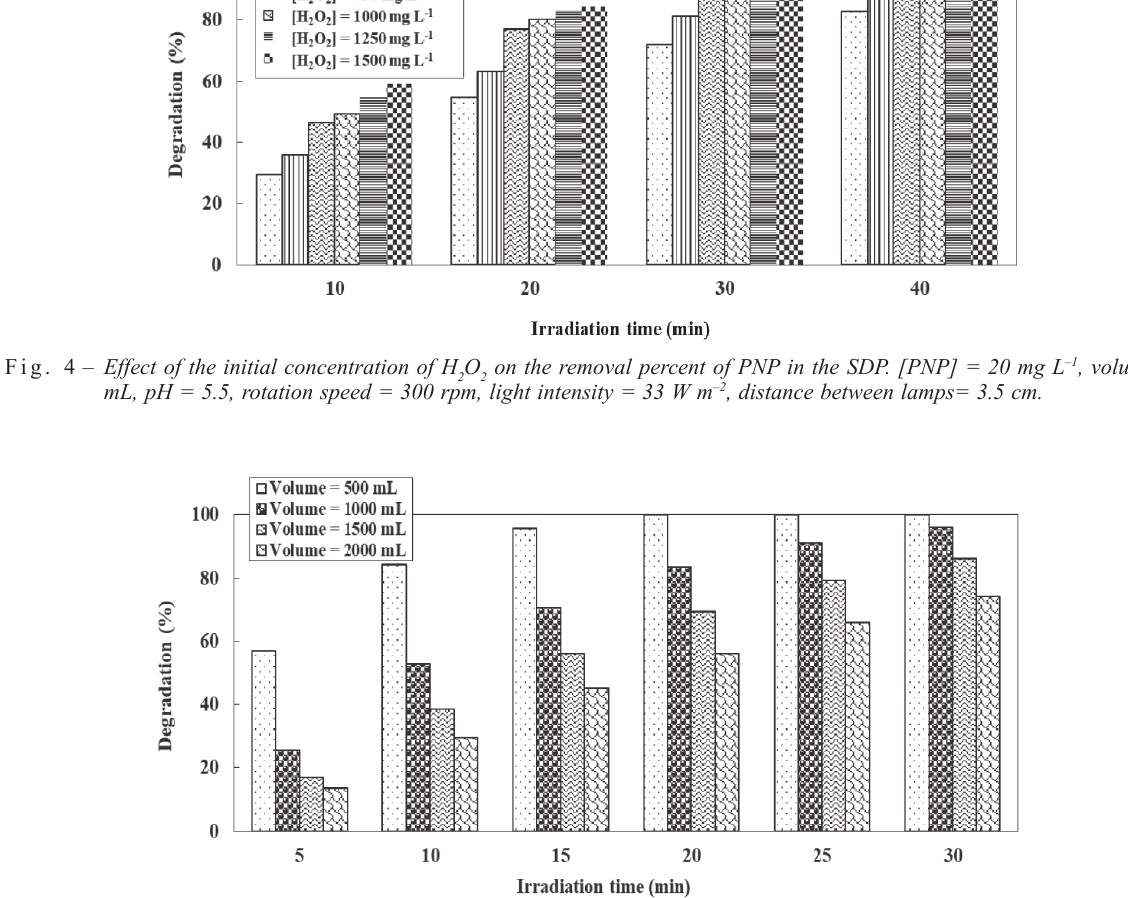
O ] = 1500 mg L –1 , 2 2